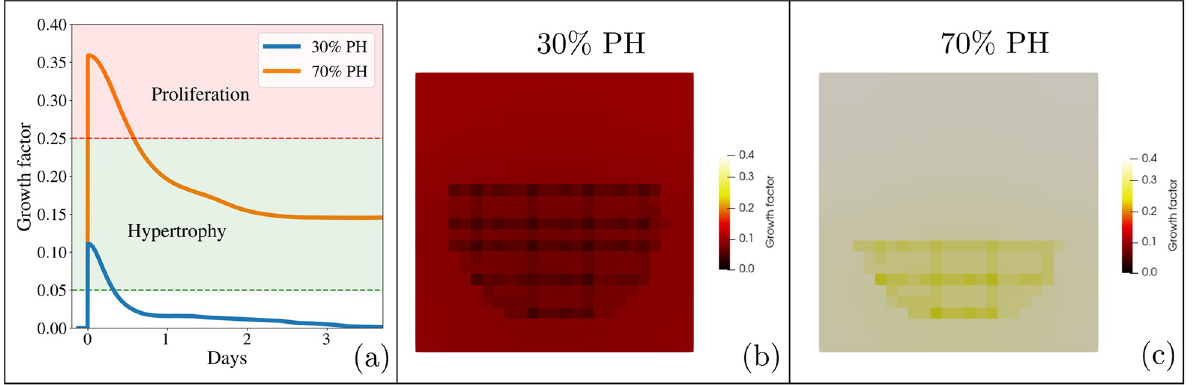
Fig 4. Growth factor. (a) Growth factor concentration in the liver microenvironment after a 30% PH (blue line) and a 70% PH (orange line), and the response it will cause in the hepatocytes. (b) and (c) Heat map of the growth factor concentration after 30% PH and a 70% PH respectively. The concentration is greater in the 70%